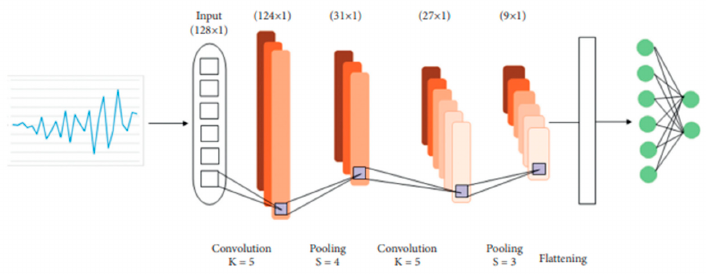
Figure 3. A CNN network example using raw acceleration input data [92] . Input data can be re- shaped in 1D or higher dimension vector